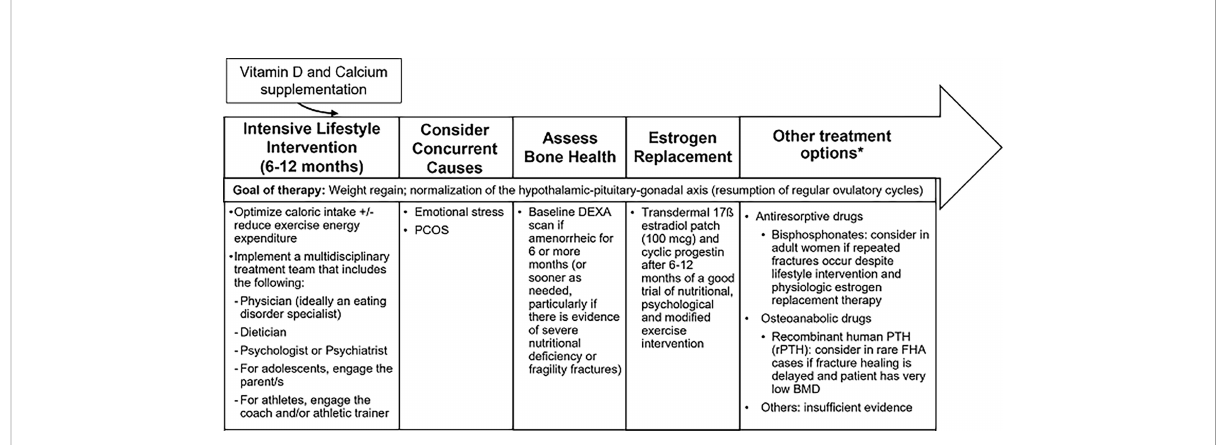
FIGURE 3 Management of Functional Hypothalamic Amenorrhea. HPO, Hypothalamic-pituitary-ovarian axis; PCOS, Polycystic ovarian syndrome; DEXA, Dual-energy X-ray absorptiometry; rPTH, Recombinant parathyroid hormone. *Treatment is similar in both adult and adolescent women except for "other treatment options" which at this time, only apply to